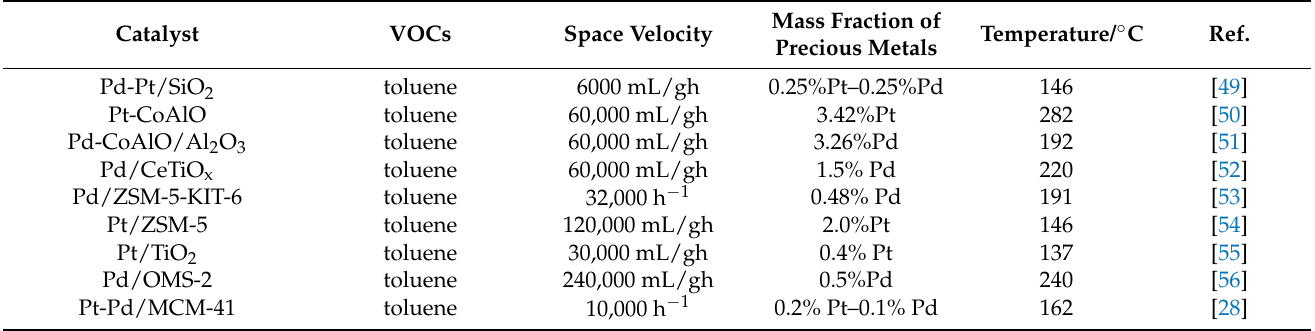
Table 1. Performance of some noble metals catalysts for the catalytic combustion of VOCs. Adapted with permission from Ref. [48]. Copyright 2019 Han